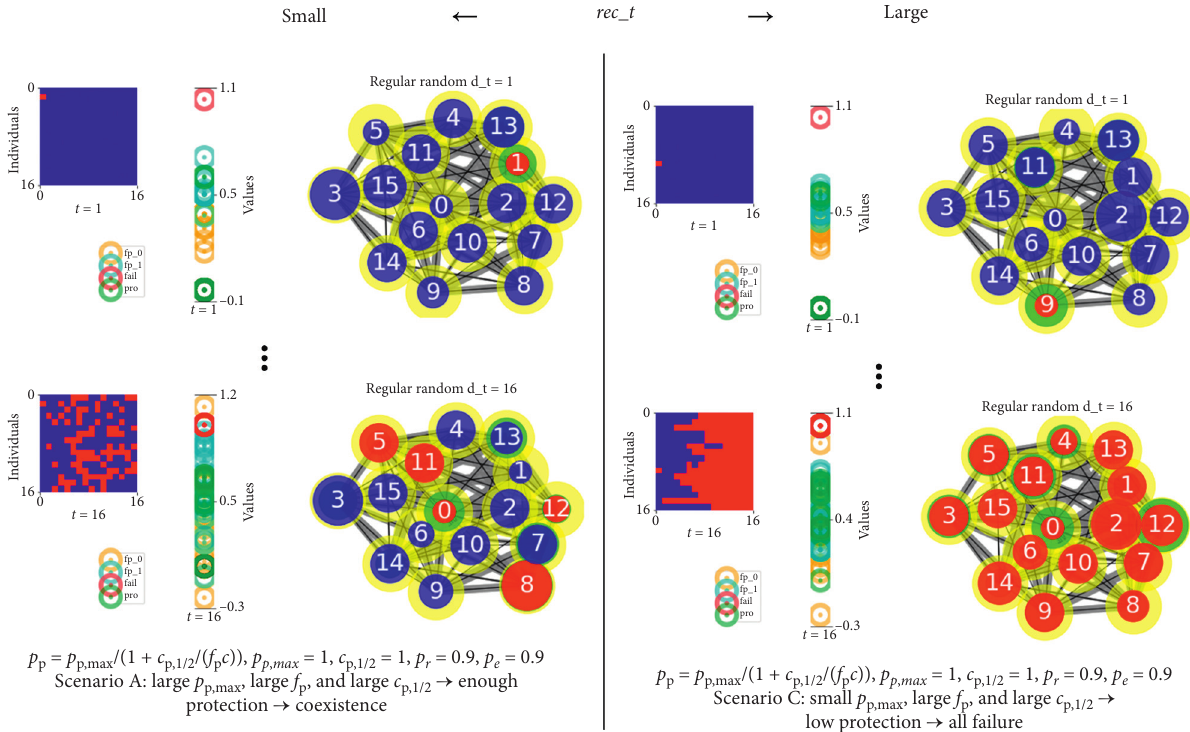
Figure 18: Dynamics of protection against systemic risk with recovery time delay. Using the same initial parameter values � 1 ,c � 1, p � 0 . 1 , p � 0 . 1 , C � 1), this set of the plots represents the time delay case (left-hand side: r_ t � 1; right-hand side: ( p p, p, 1/2 r e max r_ t � 5). In each section, the plot on the left-hand side shows the matrix (horizontal axis � time step from 1 to 16; vertical axis � individuals from 1 to 16; color of the matrix � failure state: failure [red] and absence of failure [blue]) corresponding to each individual’s parameter values at the given time step ( t � 16: orange: fp_0 � strategy [1]; cyan: fp_1 � strategy [2]; red: fail � failure; green: pro � protection potential [ p p ]). The graph on the right-hand side represents the dynamics in a random regular network, such that the node number � random label for each node and the node color � state (failure � red, absence of failure � blue) (see Appendix 3 for the results of the entire